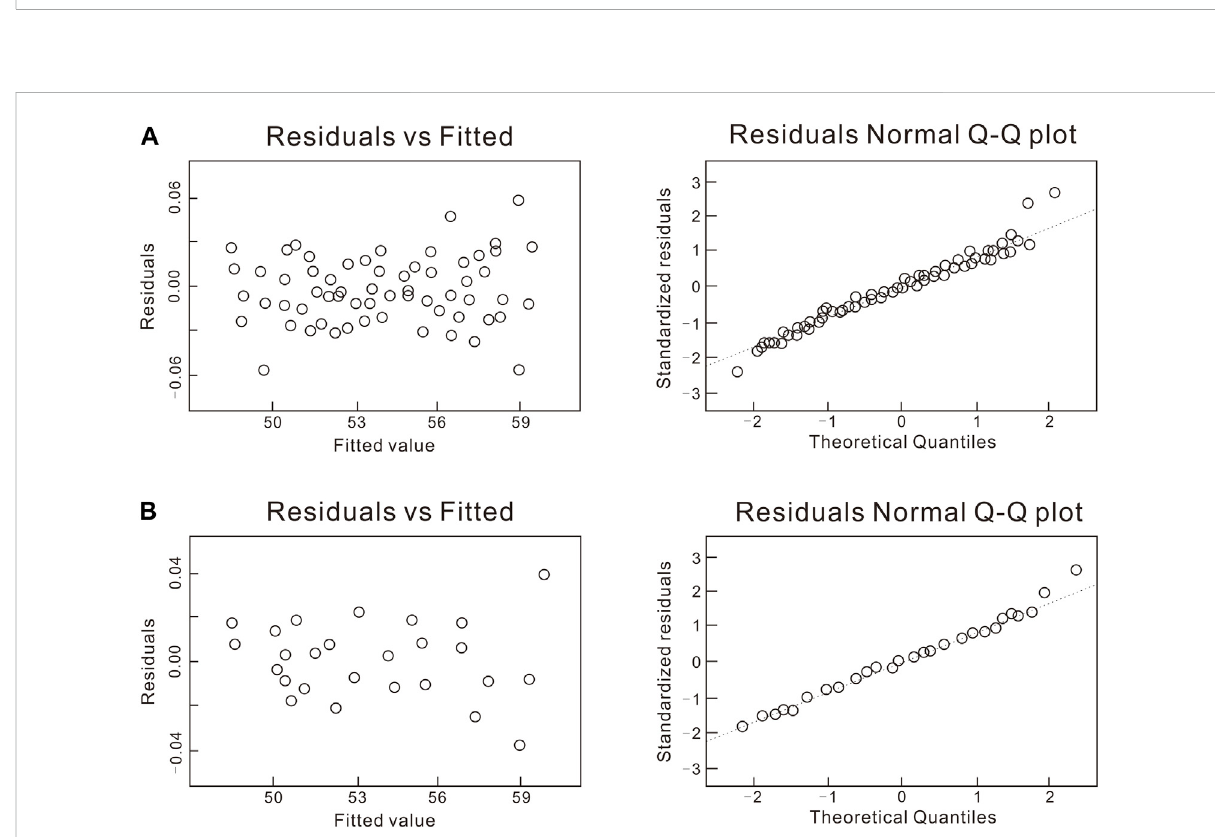
FIGURE 11 Residual plots of the (A) fi rst-order regression model with interactions and (B) Box – Behnken second-order regression model with interactions among signi fi cant parameters plus